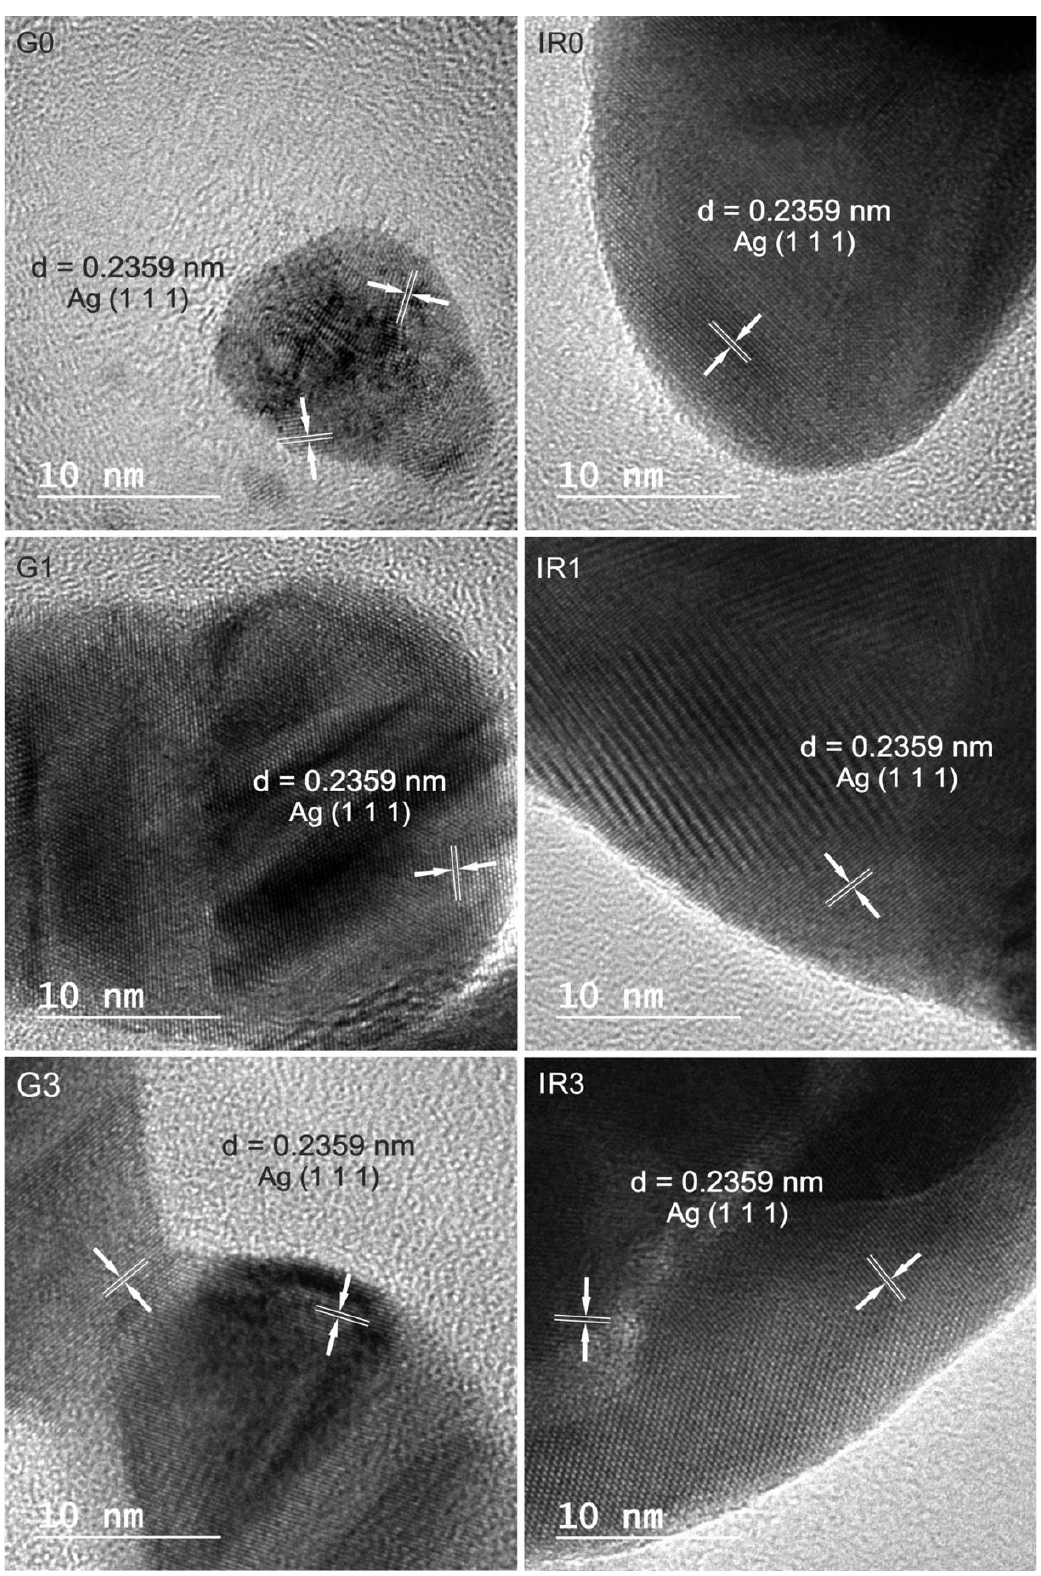
Figure 4. HRTEM images of Ag crystalline nanoparticles obtained in water ( G0 ) by laser ablation with Green-nanosecond laser, ( IR0 ) by laser ablation with IR-picosecond laser, ( G1 ) after one re-irradiation with Green-nanosecond laser, ( IR1 ) after one re-irradiation with IR-picosecond laser, ( G3 ) after three re-irradiations with Green-nanosecond laser, and ( IR3 ) after three re-irradiations with IR-picosecond laser.